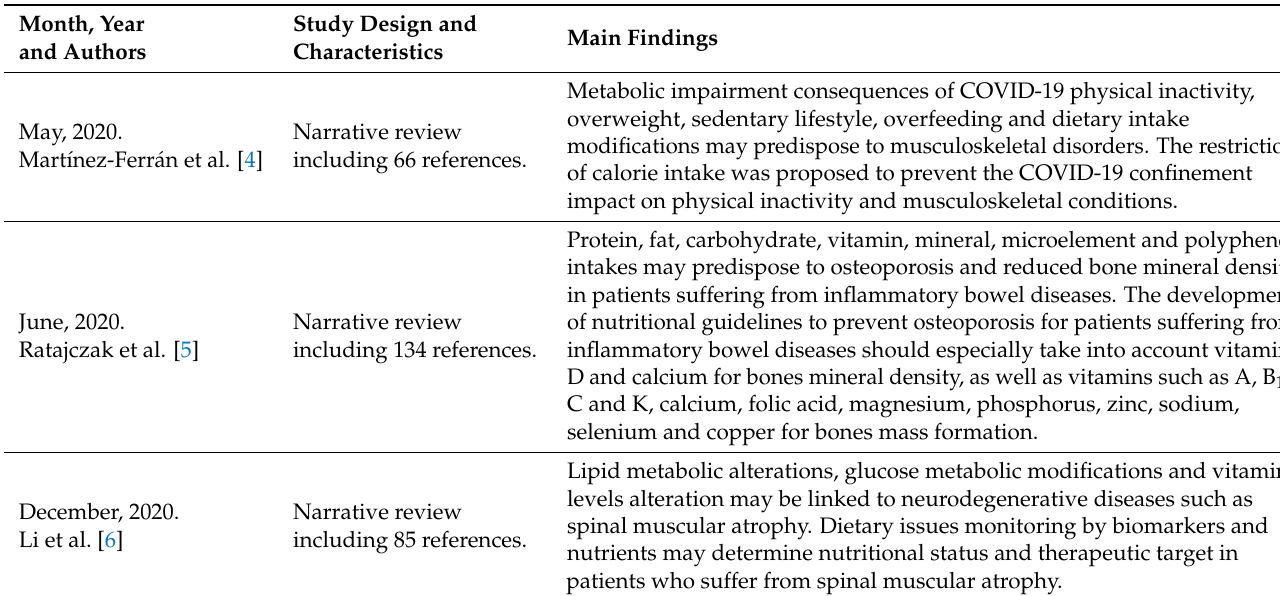
Table 1. The characteristics of the review studies included in the Special Issue about nutrients and biomarkers in muscu- loskeletal